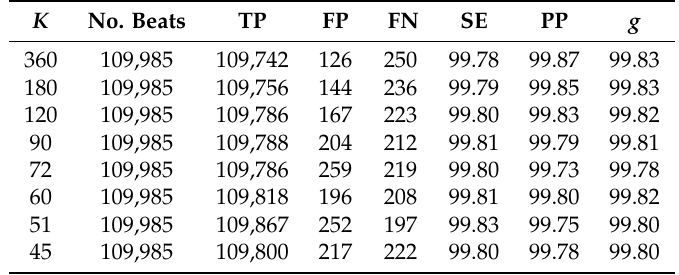
Table 1. Determining the optimal K value for Method III based on the QRS detection accuracy. Results were sorted in descending order according to the K value. TP stands for true positives (QRS complexes detected as QRS complexes), FN stands for false negatives (QRS complexes that have not been detected), FP stands for false positives (non-QRS complexes detected as QRS complexes), SE stands for sensitivity, + P stands for positive predictivity, and g is the F-score.